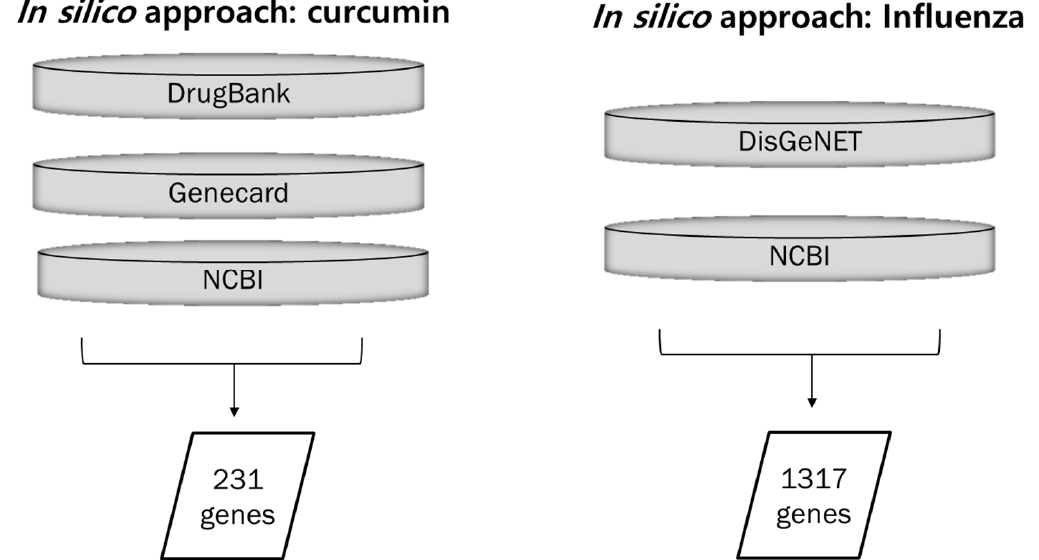
Figure 1. Collection of data for curcumin-, influenza-, and lung inflammation-associated genes. Curcumin-associated genes were collected from three databases: DrugBank, GeneCards, and NCBI. Influenza- and lung inflammation-associated genes were retrieved from two databases: DisGeNET and NCBI.